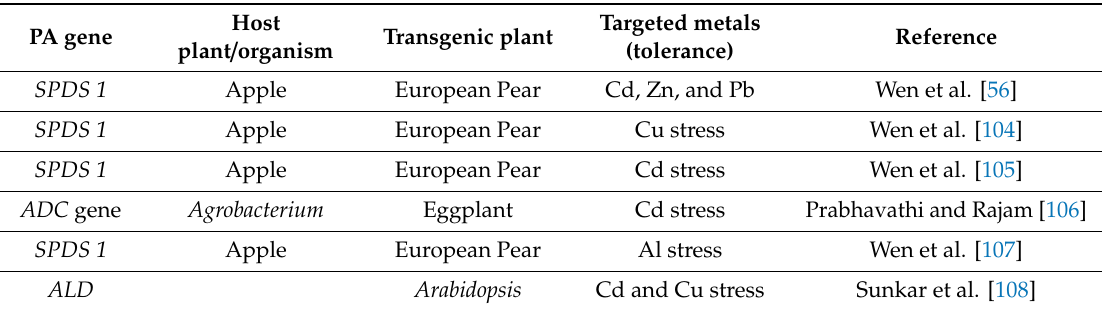
Table 3. List of transgenic plants encoding PA biosynthetic genes exhibiting high heavy metal